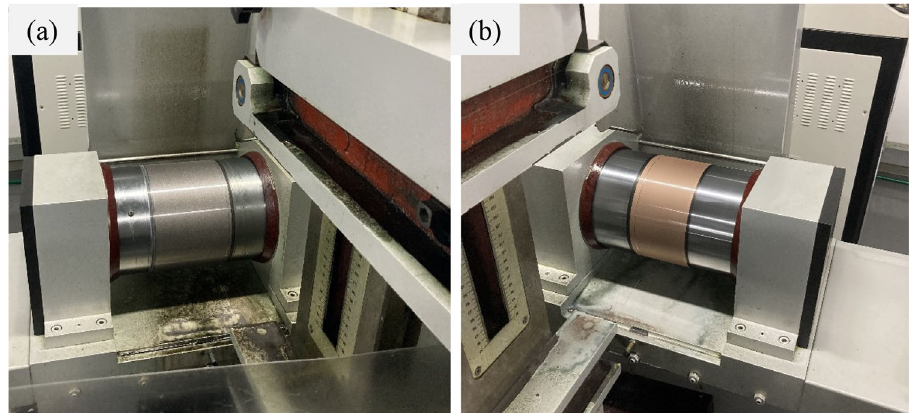
Fig. 8 Images of molybdenum wires a before and b